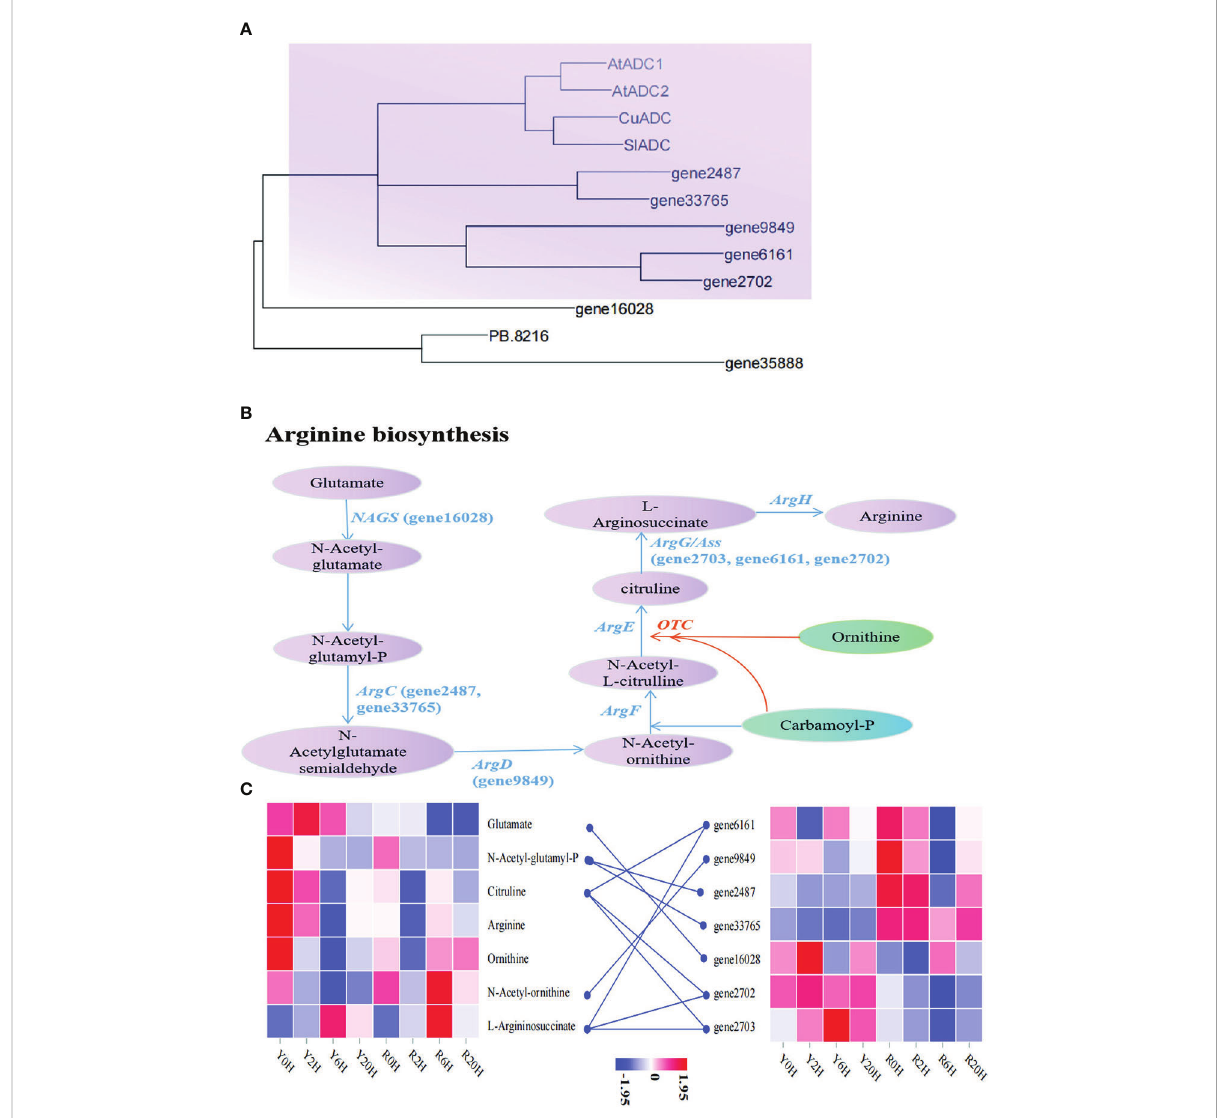
FIGURE 5 Metabolites and genes involved in arginine biosynthesis (A) Maximum likelihood phylogenetic tree of the key genes in arginine biosynthetic pathway. The colored blocks highlight the relationship between genes involved in arginine biosynthesis identi fi ed in this study and the genes of the same pathway in Arabidopsis thaliana , Cucumis sativus , and Solanum lycopersicum . (B) Arginine biosynthetic mechanisms associated with cold resistance in the rubber tree. The name in parentheses beginning with the term “ gene ” are the IDs of the genes annotated in this study. (C) The heatmap of metabolites and genes involved in arginine biosynthesis based on the FPKM of key genes and the content of